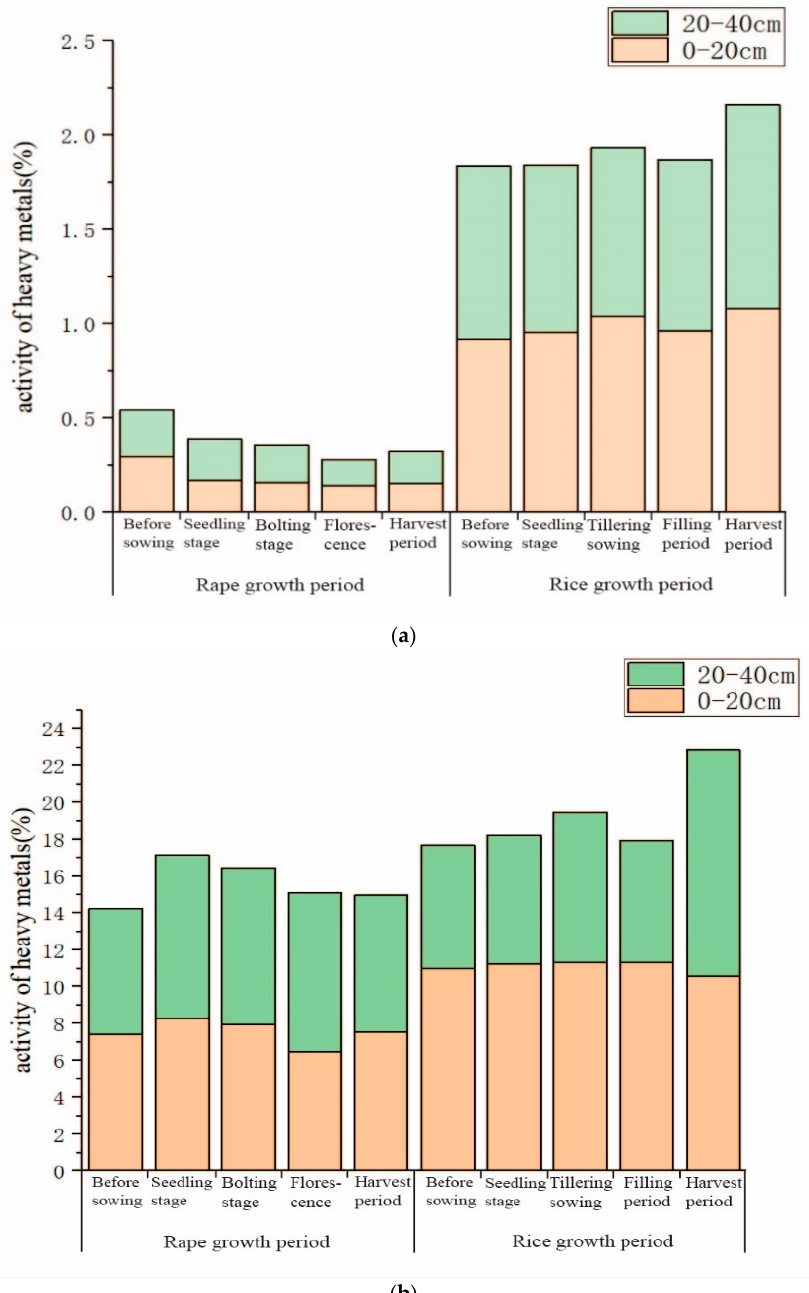
Figure 4. Variation of soil heavy metal activity under the rape-rice rotation (Notes: ( a ) is Cr, ( b ) is